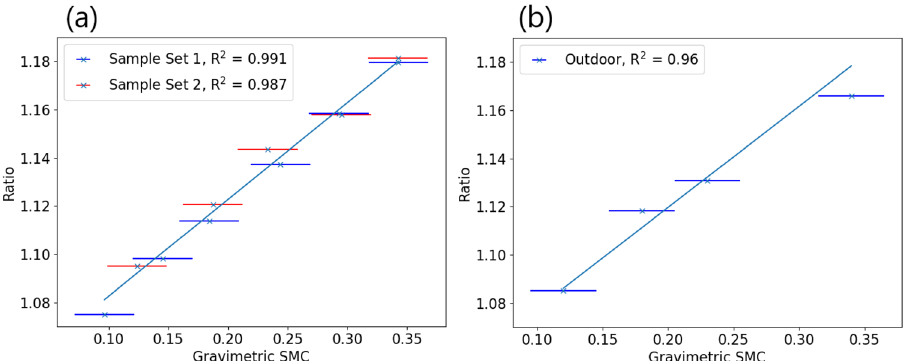
Figure 5. ( a ) Soil ratios from two sets of samples plotted against a mean calibration curve. These samples were measured under controlled illumination. The predicted and measured SMC g values agree within a 3% error. ( b ) Soil samples measured under solar illumination, plotted against the same calibration